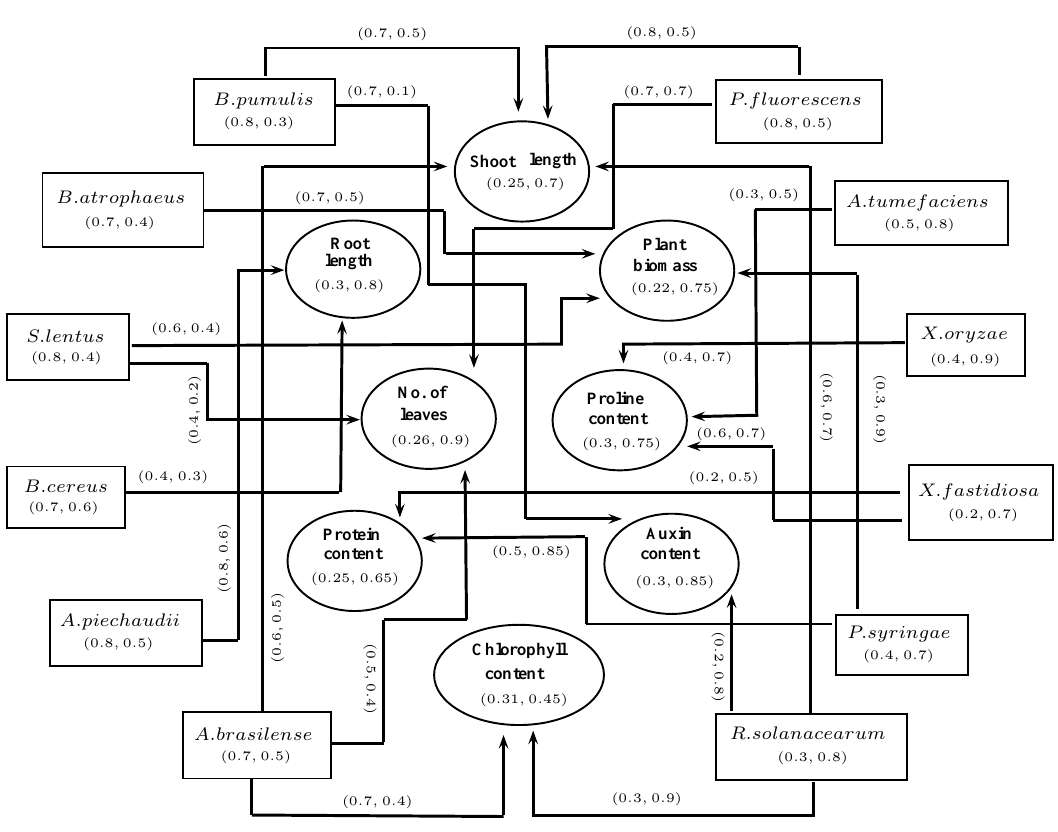
Figure 5.2: Pythagorean fuzzy soil ecosystem digraph Figure 18. Pythagorean fuzzy soil ecosystem digraph.